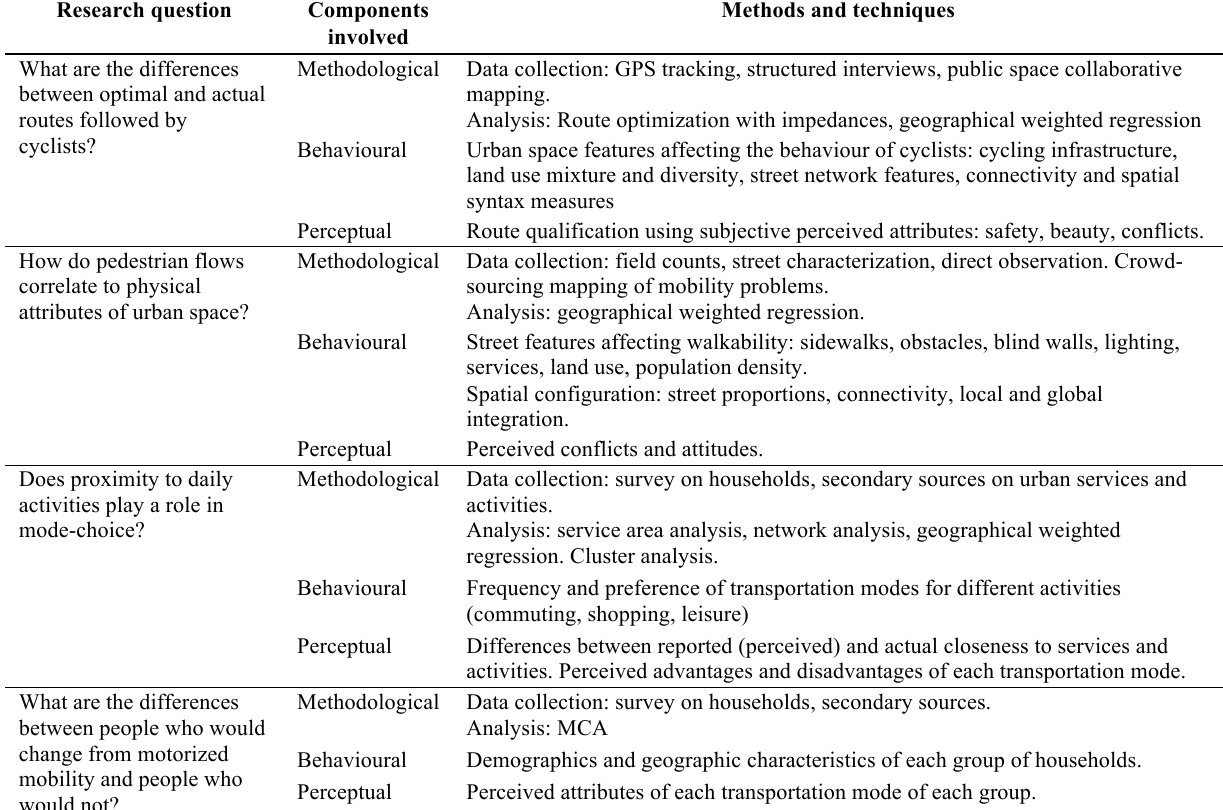
Table 1. Example of implementation of the proposed framework for the study of mobility patterns of pedestrians and